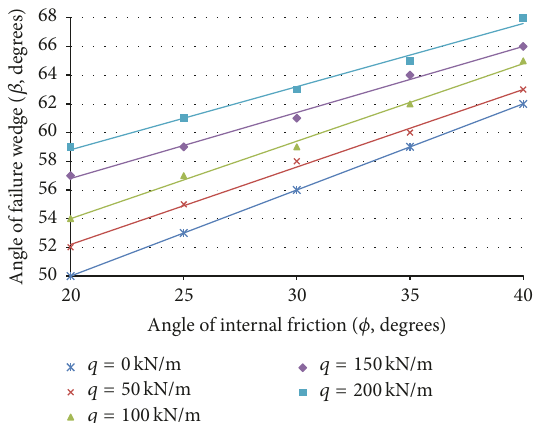
Figure 8: Changes in the angle of failure wedge against changes in internal friction angle of soil for different values of line surcharge.